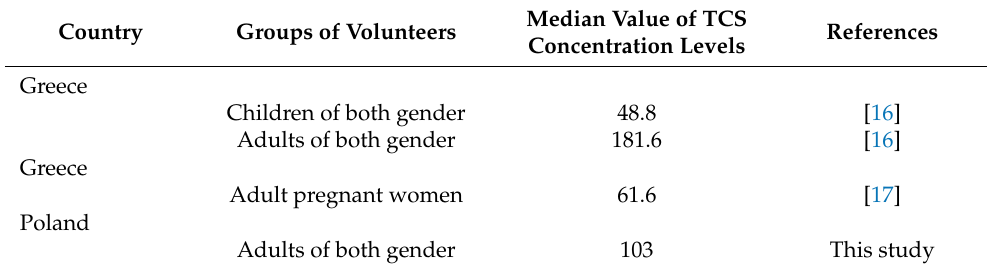
Table 5. Median values of TCS concentration levels in human hair studied with the liquid chromatog- raphy/mass spectrometry method (pg/mg). Country Groups of Volunteers